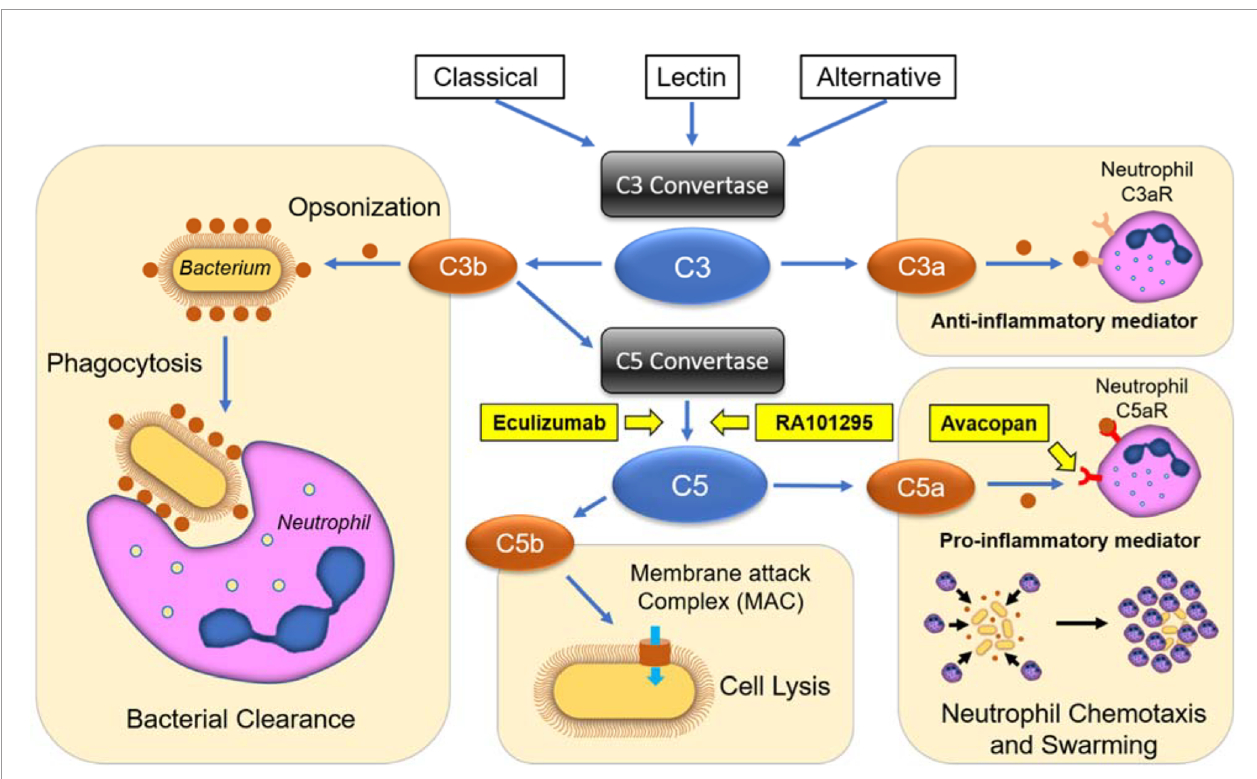
FIGURE 7 | Schematic representation of complement activation pathways, terminal inhibition strategies, and their effects on neutrophil functional behaviors. The classical, lectin, and alternative pathways converge on the cleavage of the central components C3 into C3a and C3b peptides. C3a acts as an anti-in fl ammatory mediator towards neutrophils, while C3b enhances phagocytosis through opsonization and forms C5 convertases, which cleaves C5 into C5a and C5b. C5a is a potent pro-in fl ammatory mediator and chemoattractant, while C5b forms the membrane attack complex (MAC), leading to cell and bacteria lysis. ECU and RA101295 are C5-inhibitors, which block the production of C5a and C5b peptides, while AVA blocks C5a mediated chemotaxis and pro-in fl ammatory